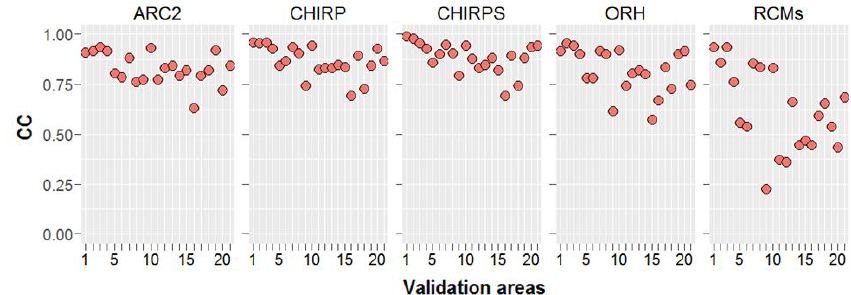
Figure 2. The correlation coefficient (CC) values between the observed monthly rainfall and data from ARC2, CHIRP, CHIRPS, ORH, and RCMs for the 21 validation areas (1–17 for EthioShed1–17, 18–19 for KenShed1 and 2, and 20–21 for TanShed1–2; see Table 1) covering the period of 1983–2005.